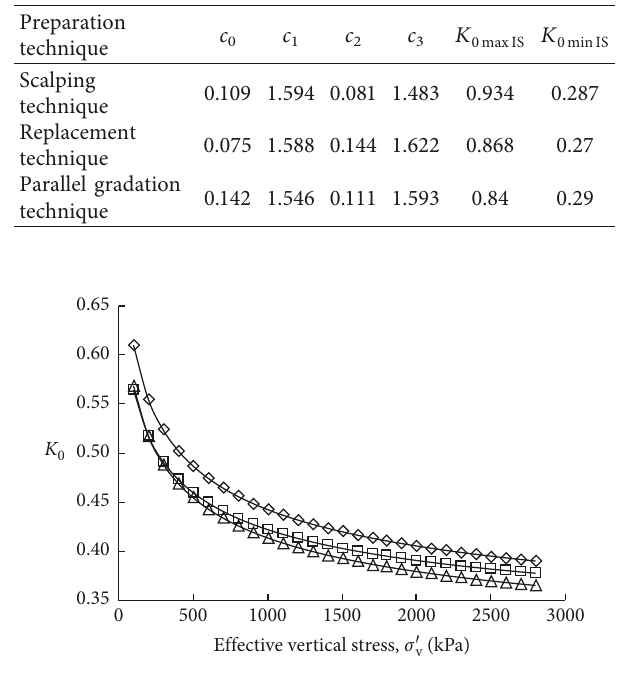
Figure 7: Testing and predicting K Table 4: Fitting parameters of the tested specimen.